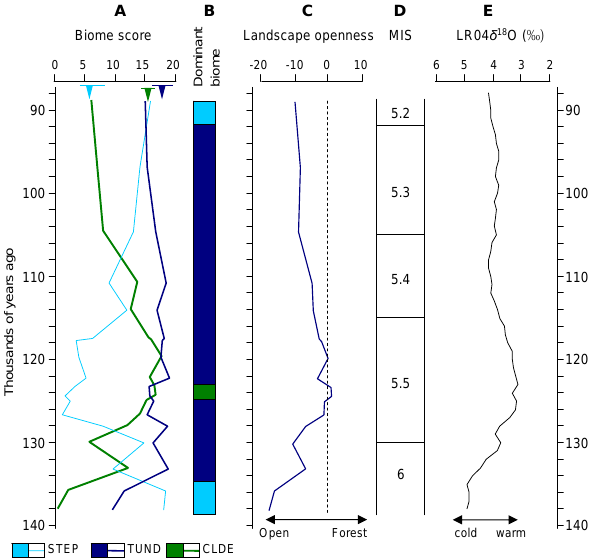
Fig. 4. Summary of paleoenvironmental trends between ∼ 138 and ∼ 89ka ago showing the (A) time series of individual biomes (tri- angles indicate the modern mean score of each respective biome; horizontal bars indicate the 95% uncertainty ranges); (B) dominant biomes; (C) characteristic of landscape openness calculated as the difference between the maximum score of forest biomes (MSFB) and the maximum score of open biomes (MSOB) at each level; and (D) marine isotope stage (MIS) boundaries and (E) stack of 57 globally distributed benthic δ 18 O records (after Lisiecki and Raymo, 2005). Biome names are abbreviated as follows: STEP